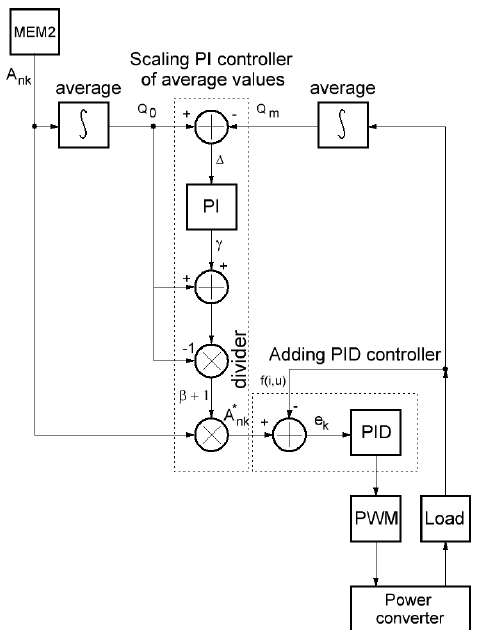
Figure 6. Block diagram for pulse shaping and the correction of systematic inaccuracies. MEM is the set point memory, and PWM is the timer with PWM output.